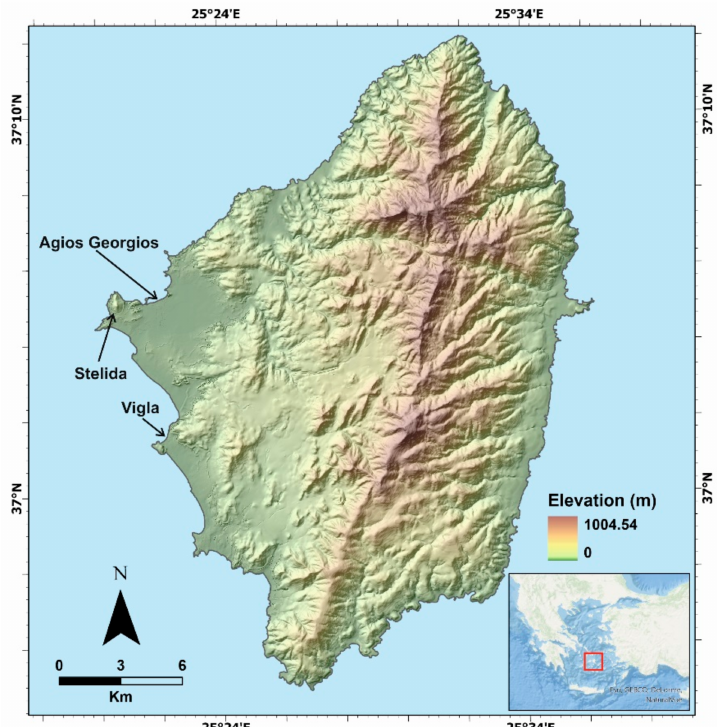
Figure 4. Location of the study area and the sites discussed in the text (created using ArcGIS